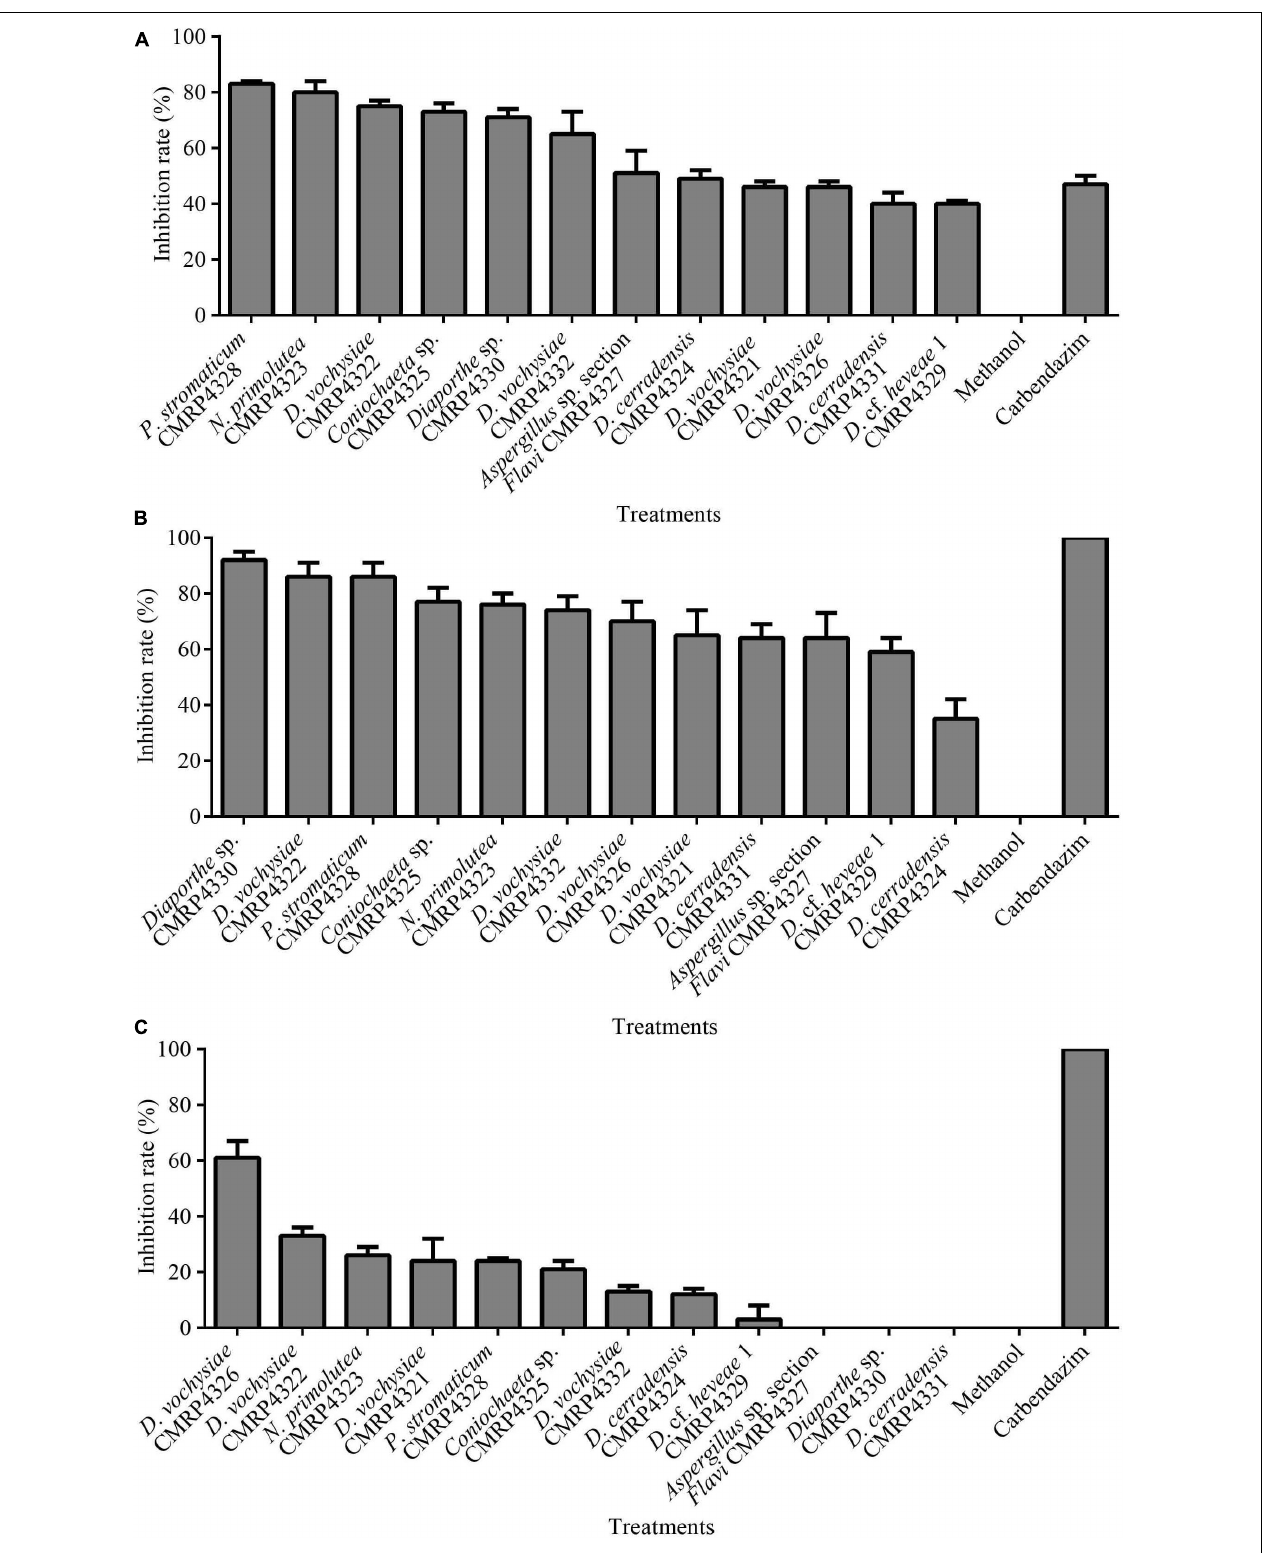
FIGURE 1 | Mean values of mycelial growth inhibition (in%) of the pathogens Colletotrichum abscissum (A) , Phyllosticta citricarpa (B) , and Fusarium graminearum (C) in the presence of 100 µ L of extracts obtained after culture of endophytes in malt extract medium. Note: Fungicide: 100 µ L Carbendazim (Derosal; 0.1 mg/mL) was used as positive